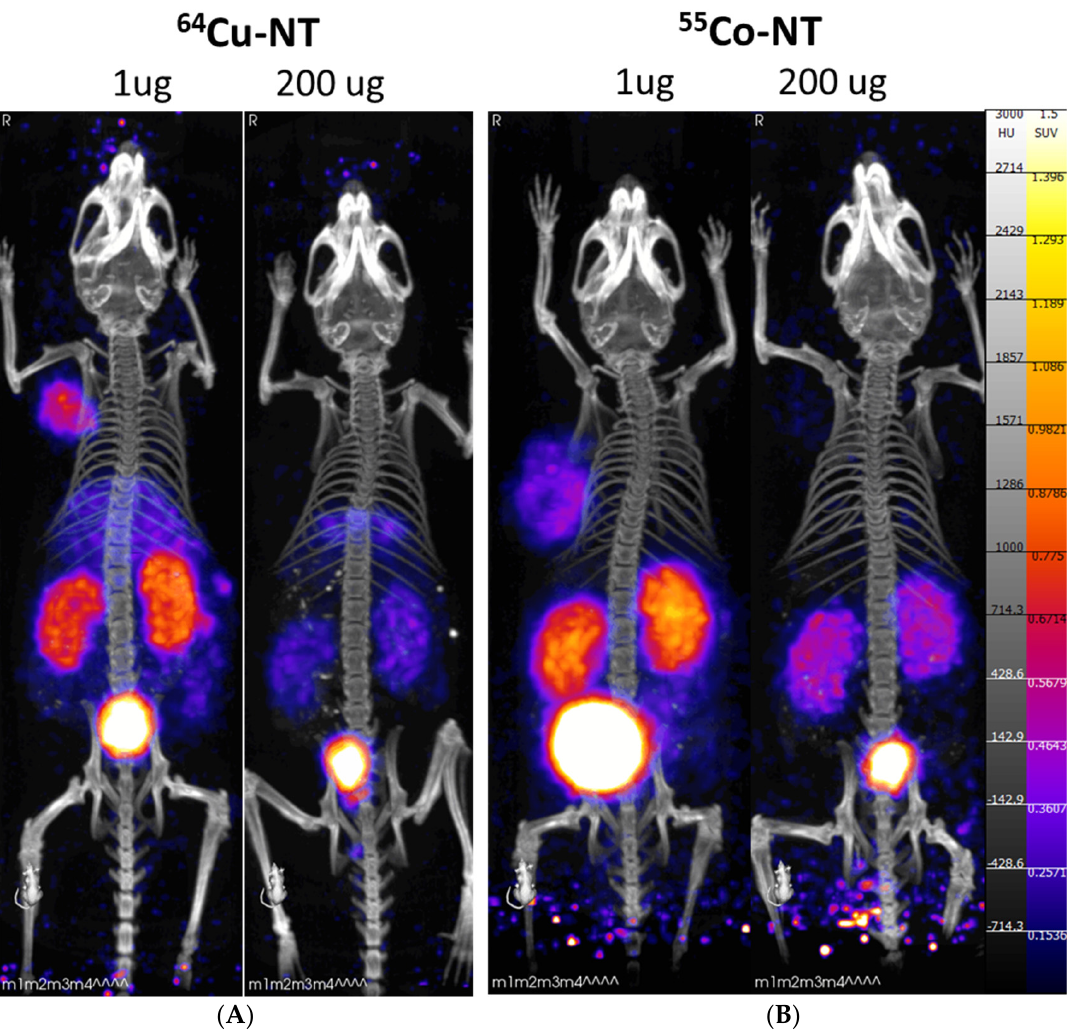
Figure 4. PET/CT imaging 4 h post-injection with radiolabeled NOTA-NT-20.3 in mice bearing HT29 tumor xenografts. Mice were imaged with [ 64 Cu] Cu-NOTA-NT-20.3 ( A ) and [ 55 Co] Co-NOTA-NT- 20.3 ( B ).